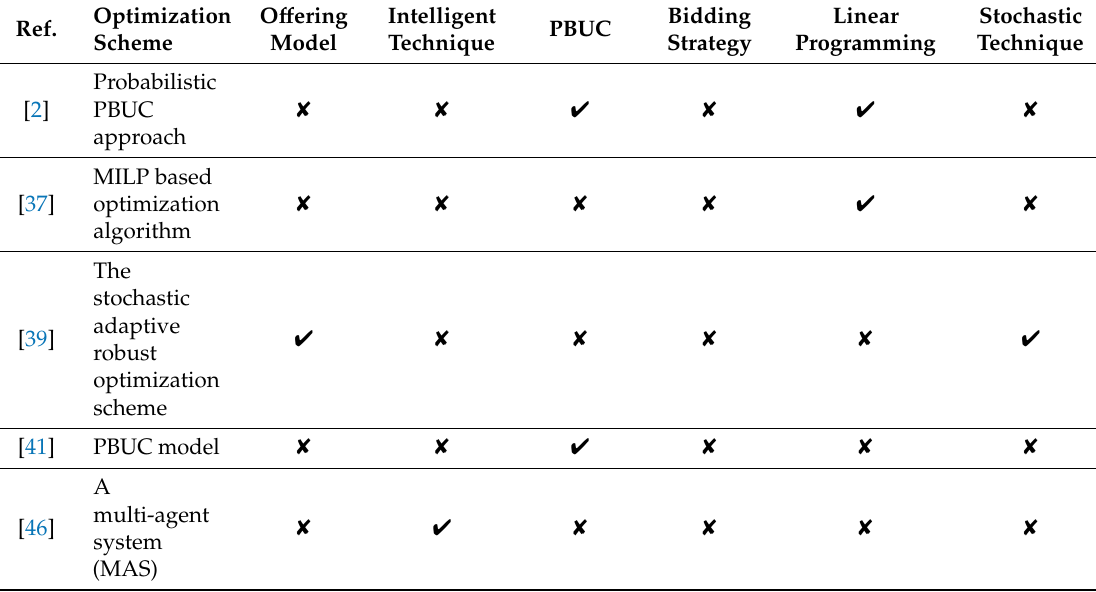
Table 8. A summarization of the optimization scheme that includes di ff erent control techniques.